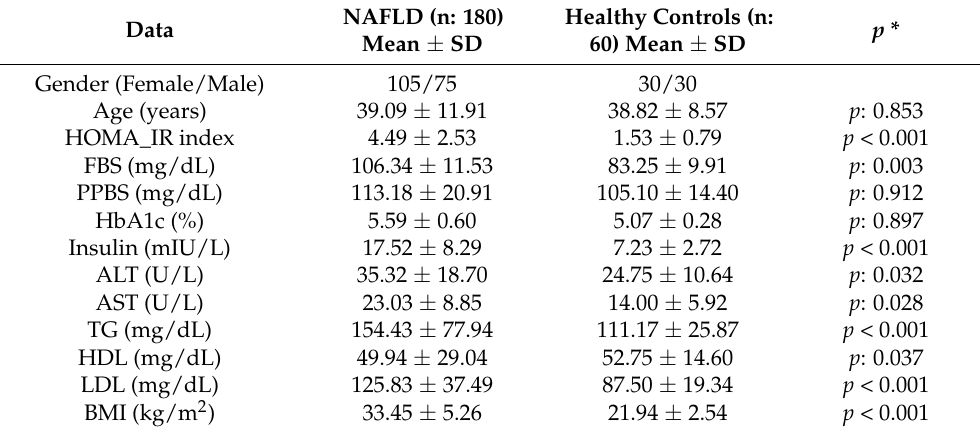
Table 1. Distribution of demographic data in NAFLD patients and healthy controls.